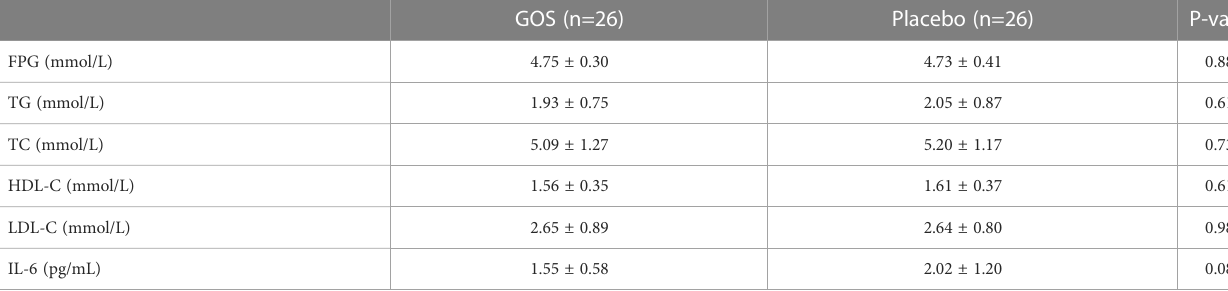
TABLE 5 Glucose metabolism, lipid metabolism and in fl ammatory factor levels.